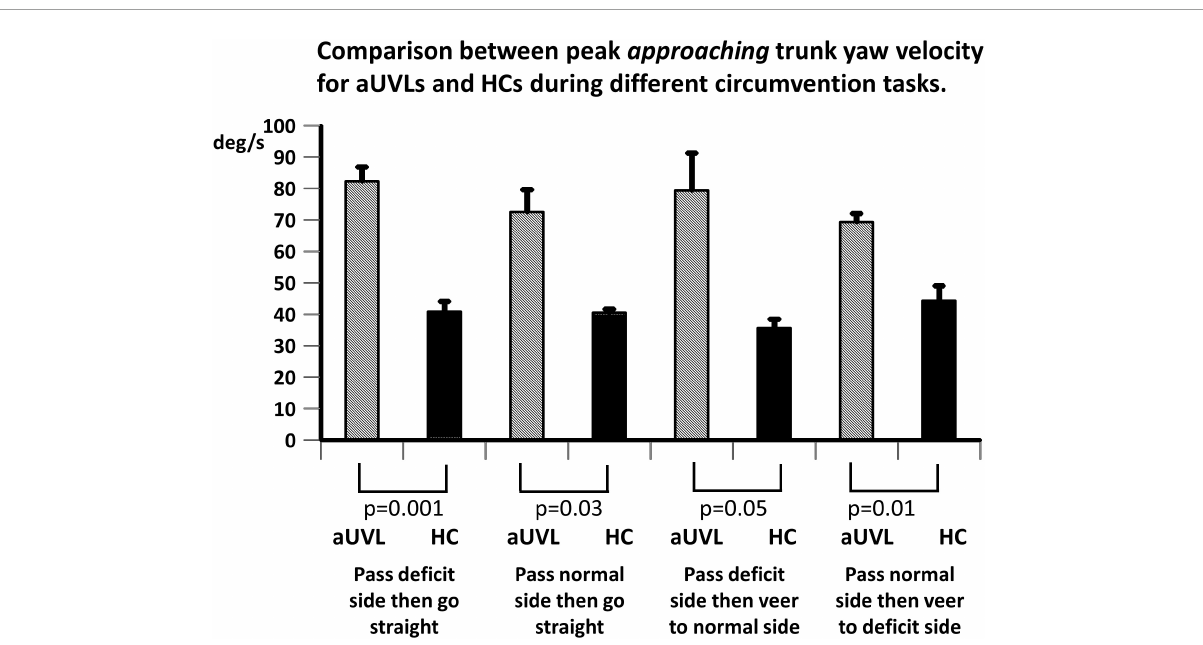
FIGURE5 Comparison between mean peak yaw angular velocity approaching toward the obstacle. Peak yaw angular velocities for patients with aUVL and HCs during different circumvention tasks, as listed below the column plots, are displayed. The height of the column represents the mean population value, and the vertical bar, the SEM. The pair-wise levels of significant differences are indicated below the